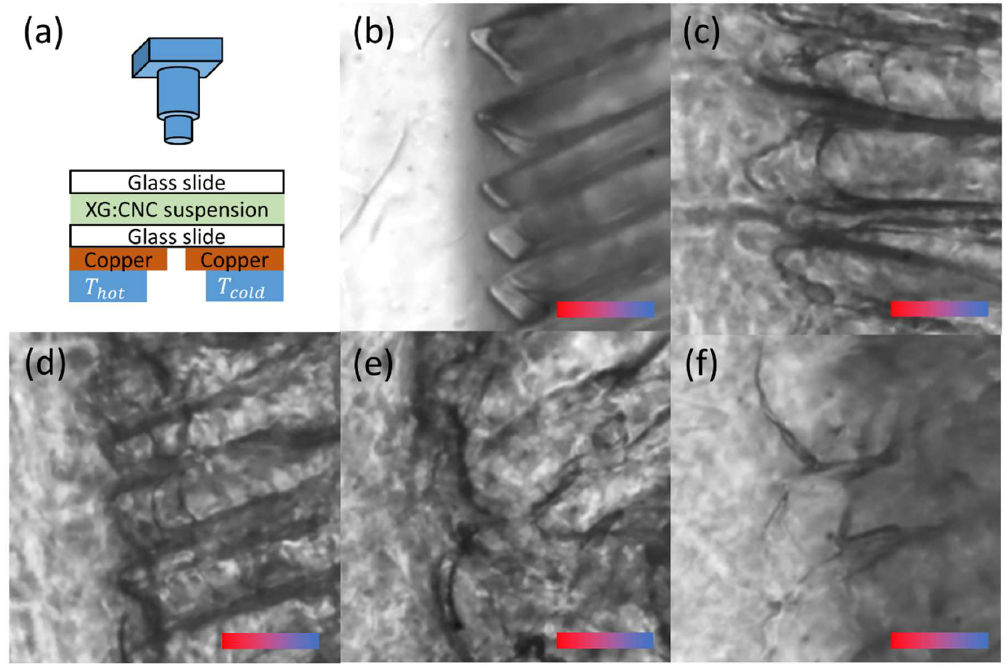
Figure 6. Directional freezing experiment: ( a ) schematic description of the translational cryostage with a fixed ΔT (T hot = 1 °C, T cold = −3 °C), and ( b )–( f ) microscope observation of samples at different XG:CNC ratios of 0:1, 1:100, 1:50, 1:10, and 1:4, respectively. Temperature gradient is shown in scale bars (100 µm, red = hot, blue = cold).